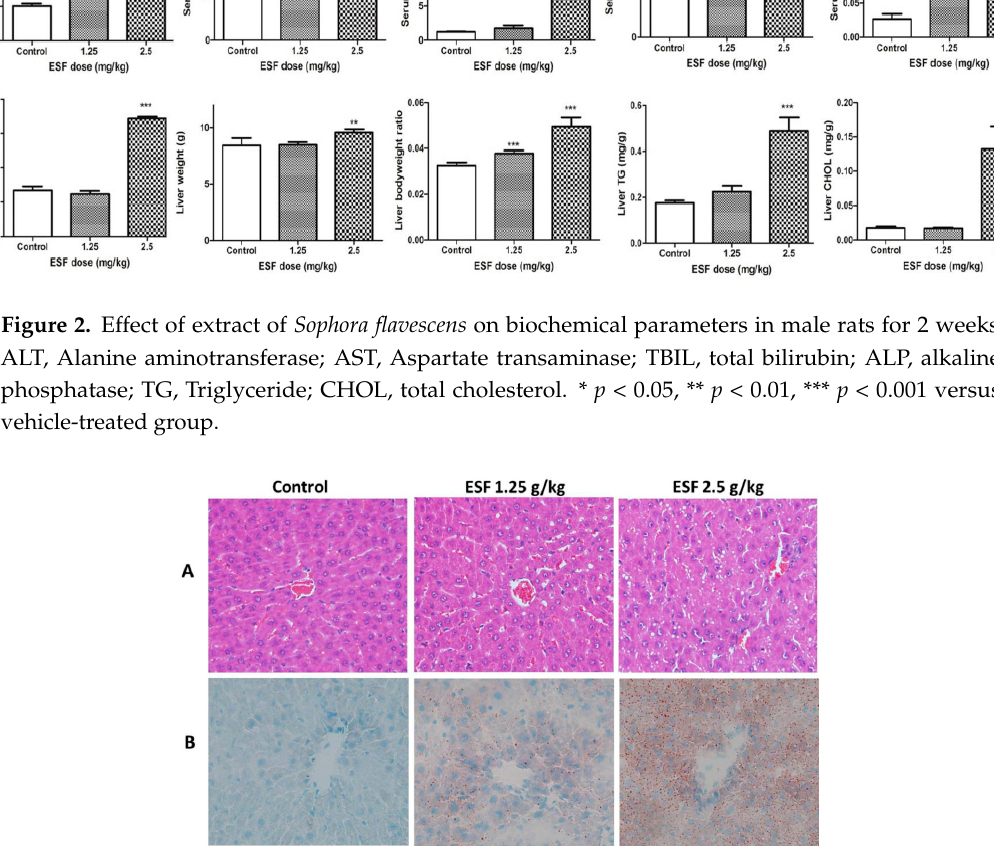
Figure 3. Hepatic histopathology of rats administered with extract of Sophora flavescens for 2 weeks (200×). ( A ) Hematoxylin and eosin staining; ( B ) Oil-red O staining.